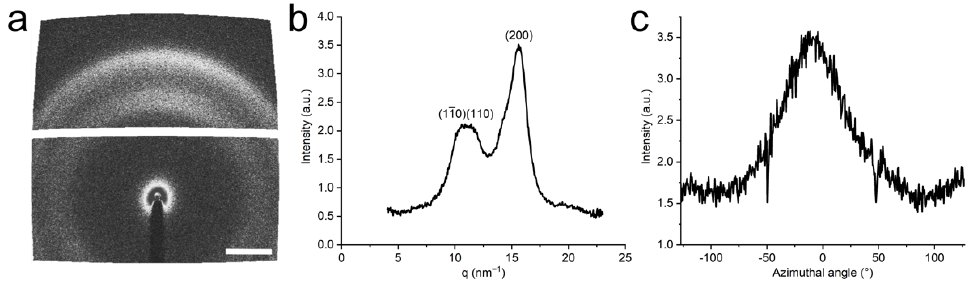
Figure 4. Cellulose crystal orientation in the filaments. ( a ) A representative WAXS diffractogram of a CNF filament in the bundle. The scale bar represents q = 5 nm − 1 . Sample direction is set on equatorial direction. Sample and nanofiber directions coincide. ( b ) Radial integration of the diffractogram after background subtraction. ( c ) Azimuthal integration of the ( 110 ) and (110) scattering planes, q = 11 ± 0.5 nm − 1 . The zero degree of azimuthal angle is set on meridian. Orientation index values ranging from approximately 0.56 to 0.82 have been